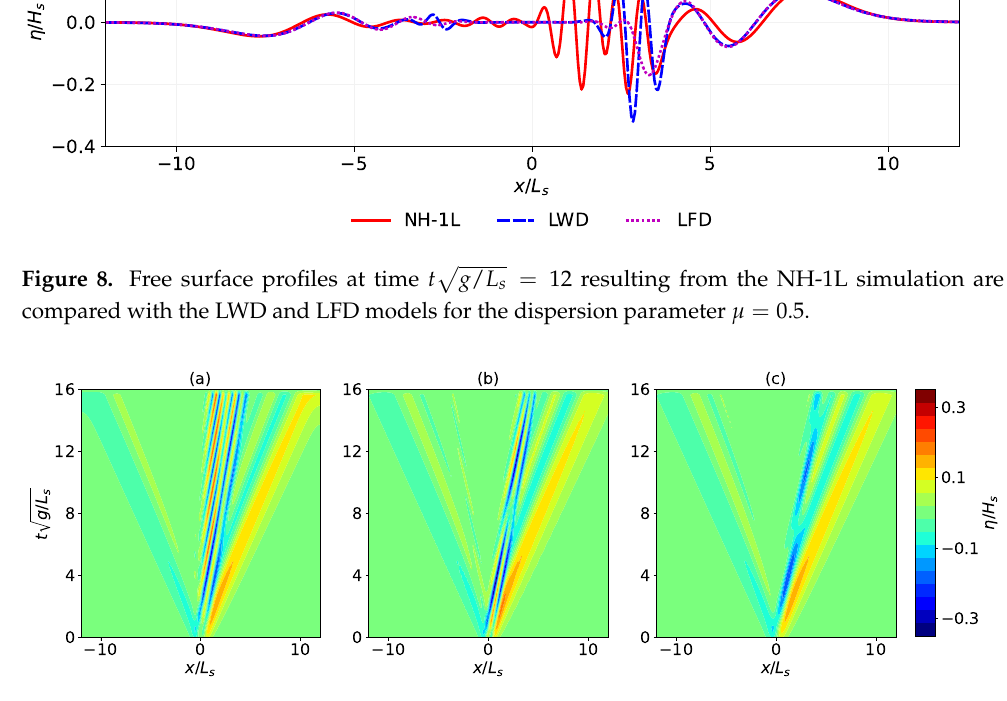
Figure 9. Comparison of wave-field contours obtained by different models with the µ = 0.5: ( a ) NH- 1L model. ( b ) LWD model. ( c ) LFD